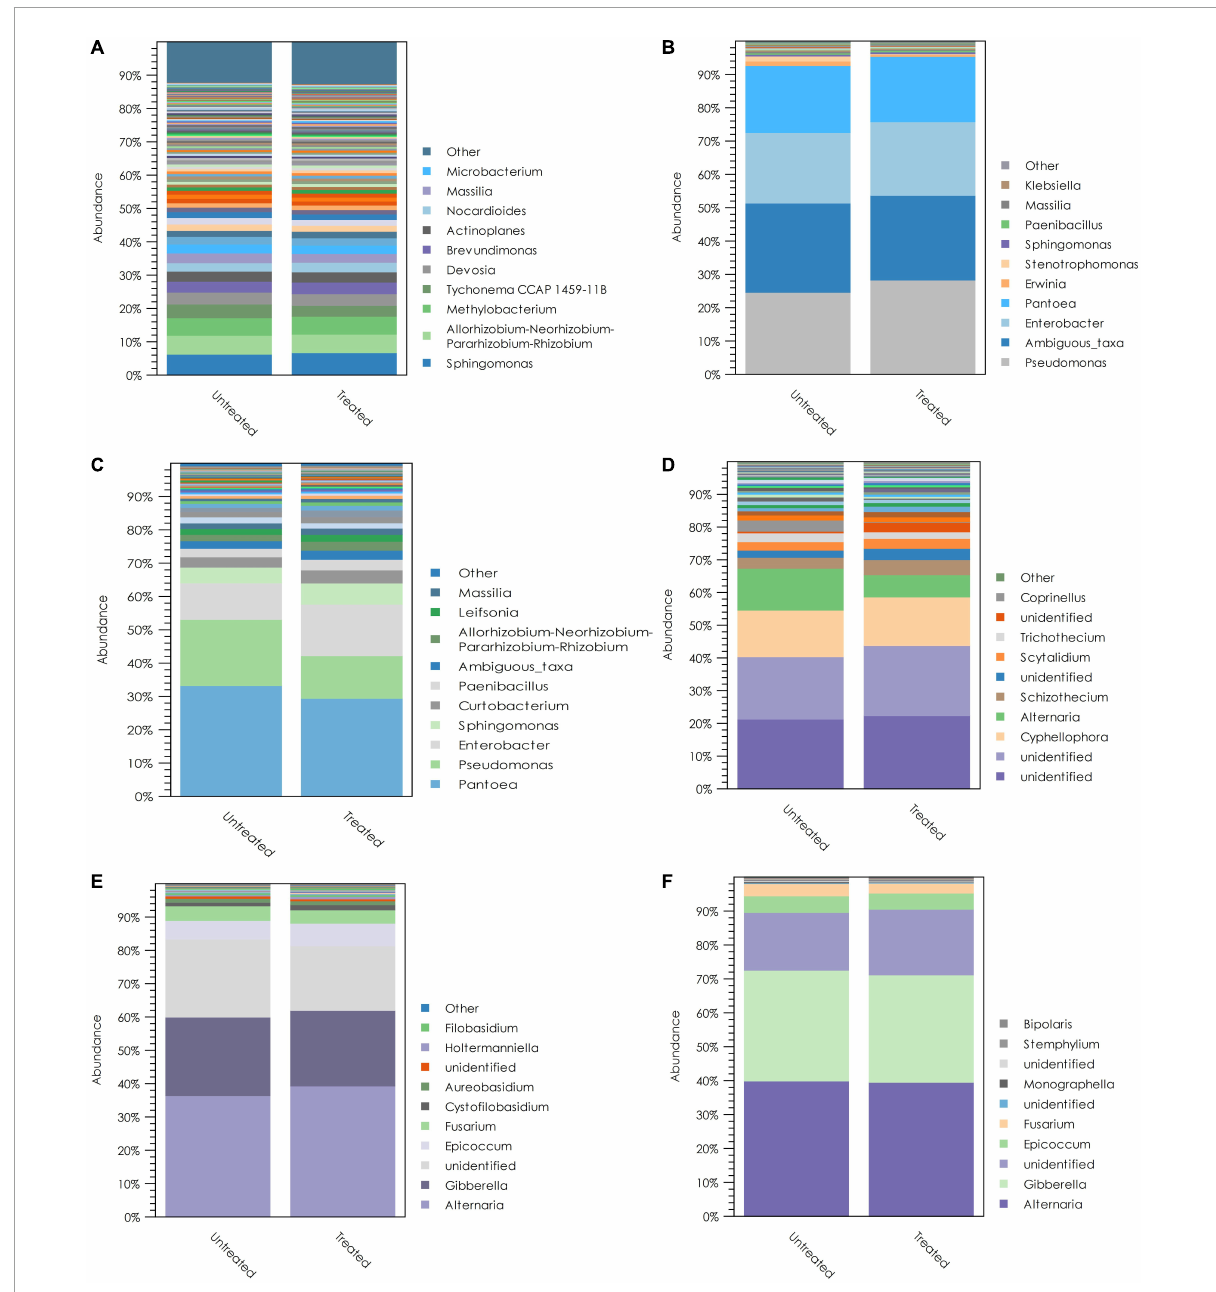
FIGURE7 The dominant taxa and average relative abundances of bacterial taxa in (A) crop residue; (B) wheat spikes; (C) wheat kernels; and fungal taxa in (D) crop residue; (E) wheat spikes; (F) wheat kernels. Within each panel, the legend lists the ten most abundant genera, differentiated by color. Treatments have been grouped according to whether or not T. gamsii T6085 was applied to the tissue in question, and mean values are